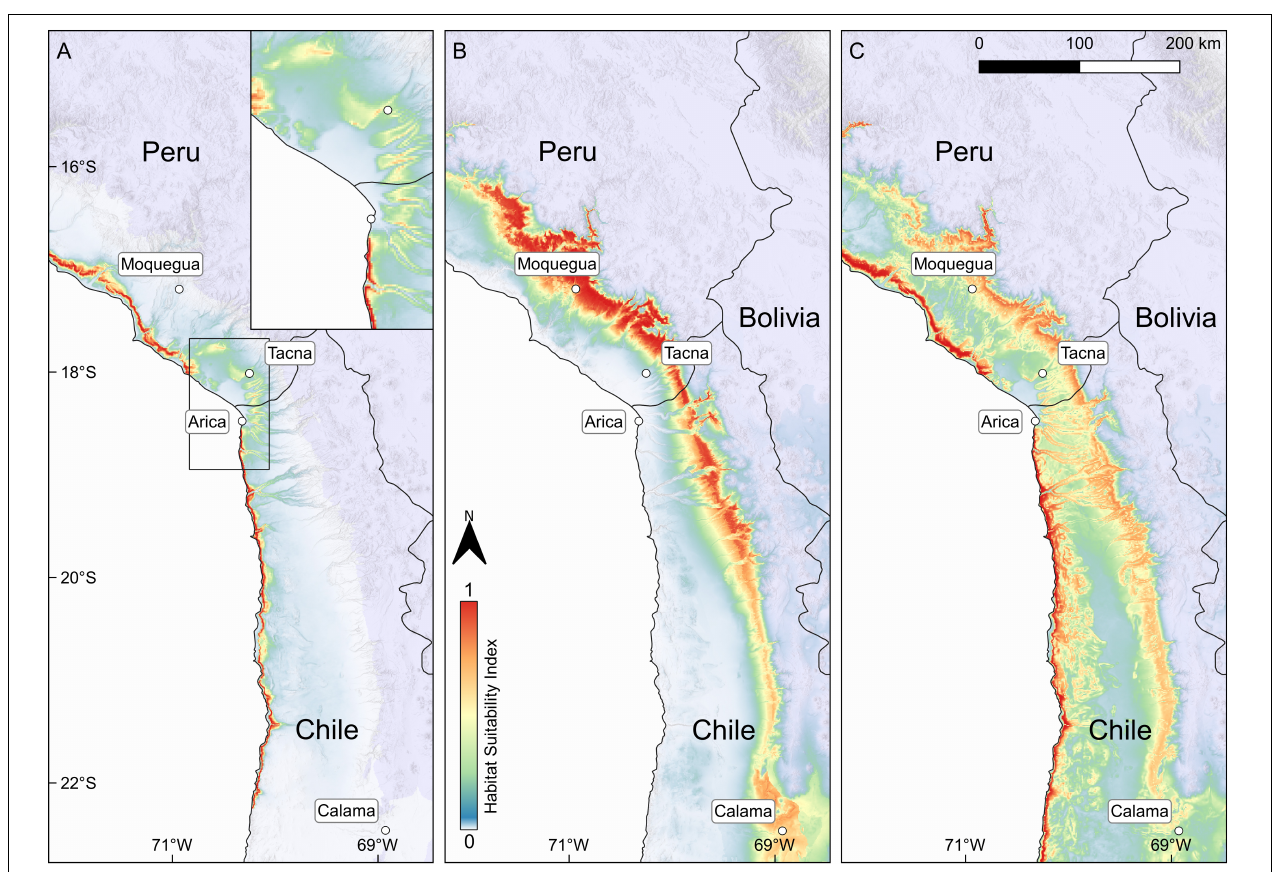
FIGURE 7 | Habitat suitability models of (A) loma- (B) precordillera- and for (C) the entire vegetation in the southern Peruvian- and northern Atacama Desert. For each vegetation type the model with highest AUC and lowest MAE is presented. Final maps were created in QGIS 3.14.16. Country layers were taken from Natural Earth (www.naturalearthdata.com). City layers were taken from MapCruzin (www.mapcruzin.com). Hillshade layer was taken from ESRI (Environmental System Research Institute [ESRI], 2020). Information on mean elevation of each raster cell (resolution: 30 s) was taken from GMTED2010 (Danielson and Gesch, 2011). For the interactive map see: https://rpubs.com/JRuhm/twosidessamedesert2022. Permission to reuse and Copyright.